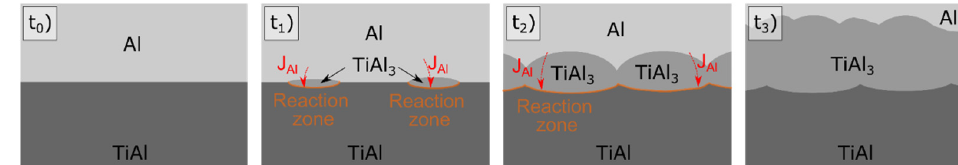
Figure 15. Mechanism for the phase evolution of the pure Al coating on the TNB-V2 substrate alloy during the vacuum heat treatment at 600 °C over time (t 0 < t 1 < t 2 < t 3 ).